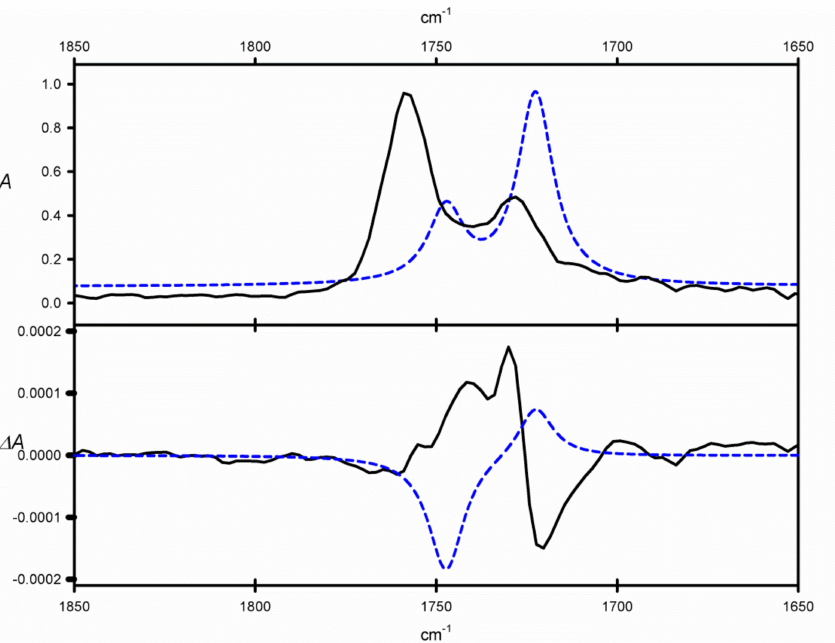
Figure 3. IR (upper panel) and vibrational circular dichroism (VCD) (lower panel) spectra of 9 , measured in CCl 4 (solid black lines) and calculated (blue dashed lines) for geometries optimized at the IEFPCM (CCl 4 ) / B3LYP / 6-311G(d,p) level. The calculated VCD spectra were Boltzmann-averaged based on ∆∆ G values and were not scaled. Only the region of C = O absorption (1850–1650 cm − 1 ) is shown. The experimental, measured in the region between 850 and 2000 cm − 1 and calculated IR and VCD spectra are available in Supplementary